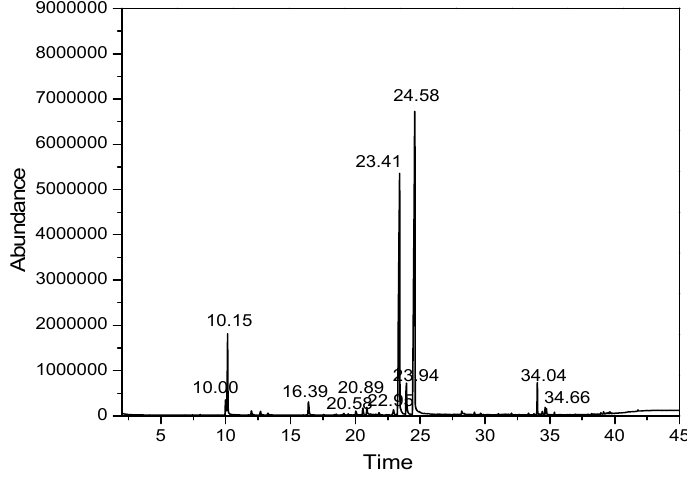
Figure 1. The spectrum of lemongrass essential oil samples.